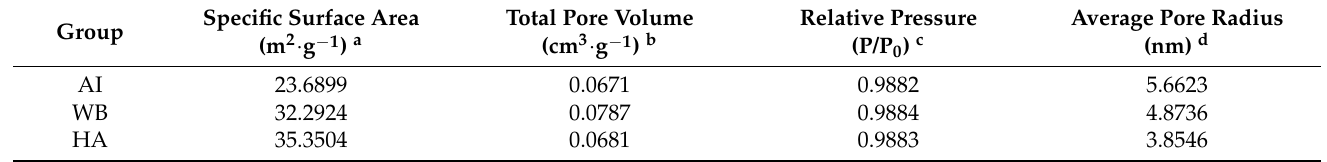
Table 6. Pore structure parameters of the carbonation layers of the